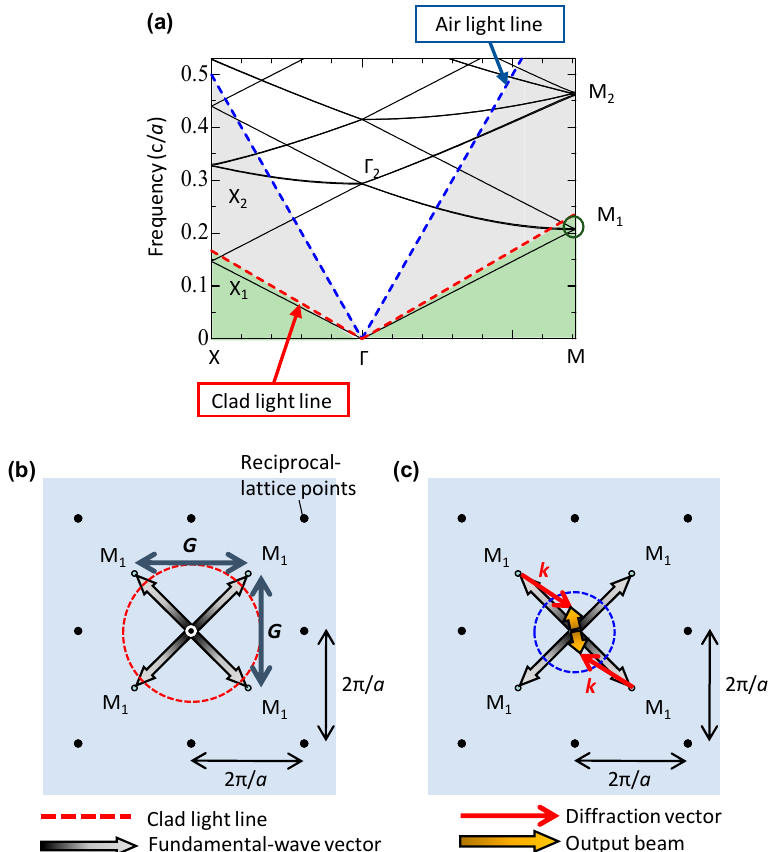
Figure 8. ( a ) Photonic-band structure of a square-lattice photonic crystal. ( b ) Coupling of states of light at the M-point in reciprocal-lattice space. ( c ) Introduction of diffraction vector k for emission in a targeted direction. © 2017 IEEE. Reprinted, with permission, from [15].